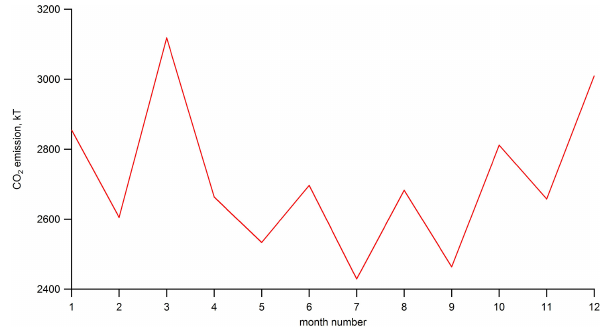
Figure 2. Integrated monthly mean FF CO 2 emission from the ter- ritory of St Petersburg, according to ODIAC2019 data in